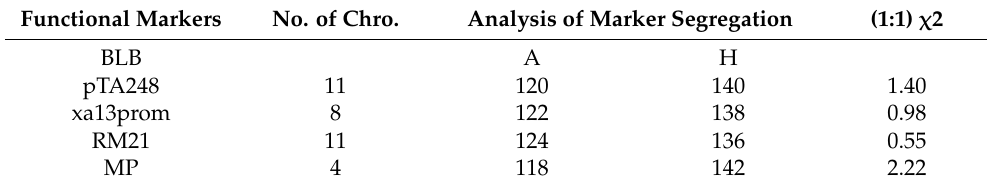
Table 3. The BC 2 F 1 progenies: Foreground marker segregation analysis. Functional Markers No. of Chro. Analysis of Marker Segregation (1:1) χ